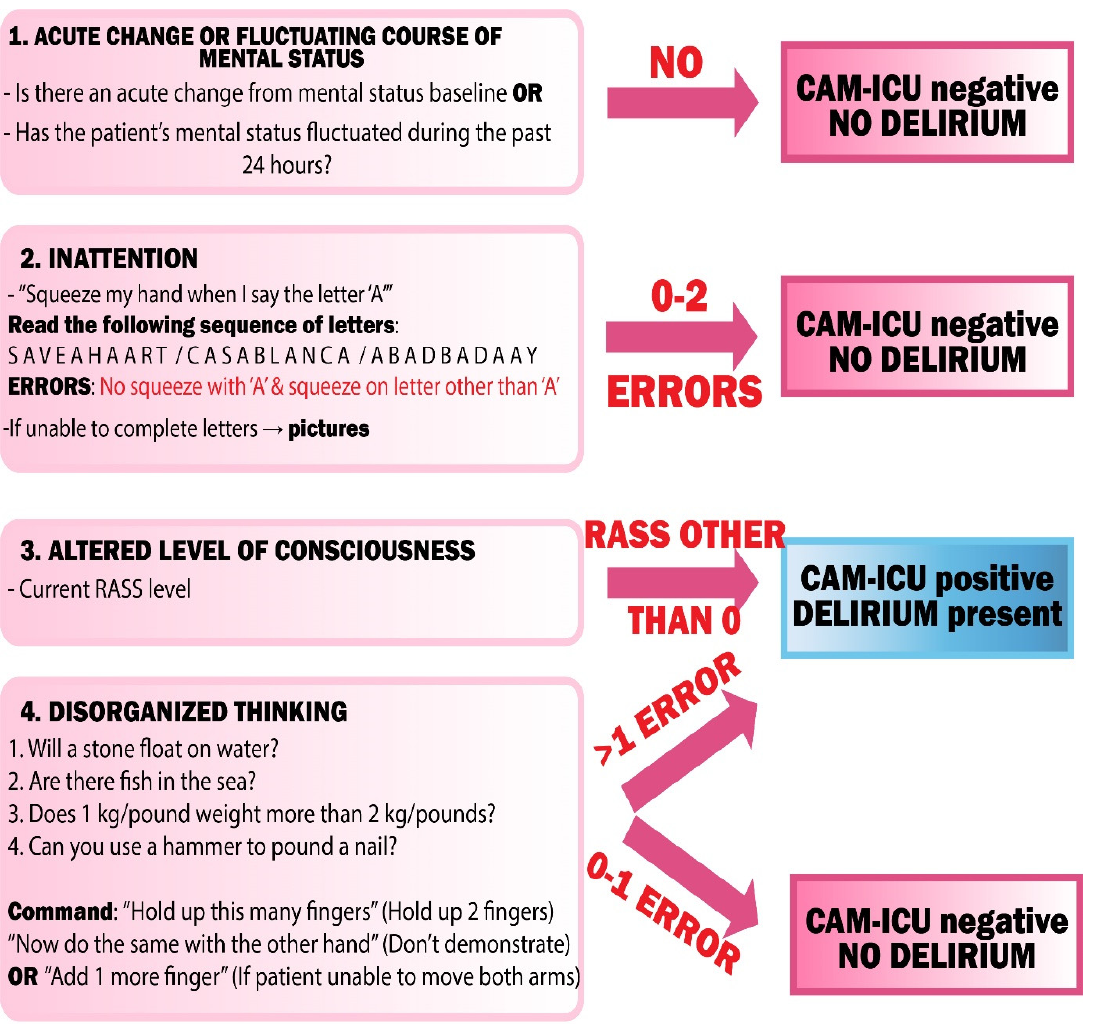
Figure 5. CAM-ICU flowsheet. CAM-ICU — Confusion Assessment Method — Intensive Care Unit, RASS — Richmond Agitation Sedation Scale. Table 4. Di ff erential diagnosis of delirium superimposed on dementia (DSD)